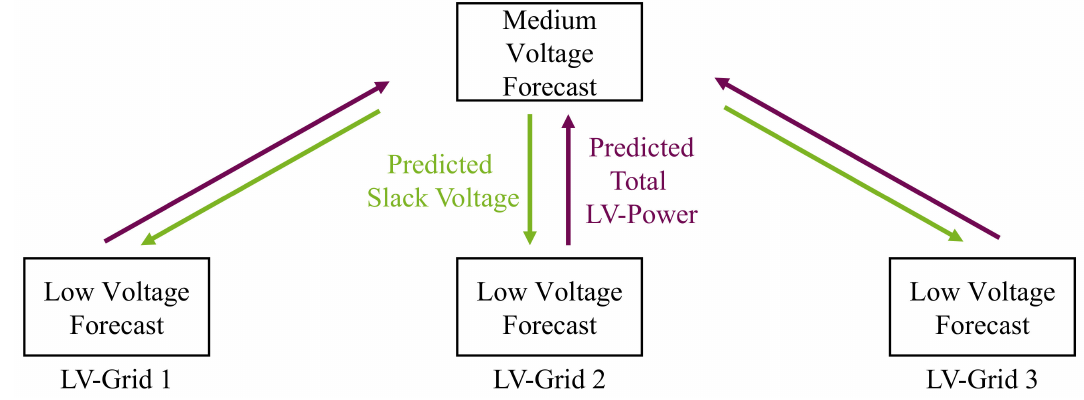
Figure 11. Procedure of exchanging information between the forecasts of two voltage